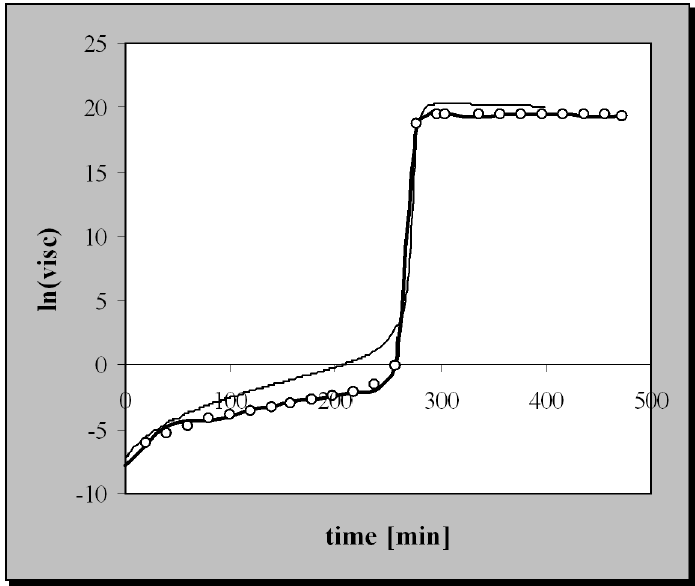
Fig. 13 Mass reaction viscosity obtained with MLP (3:12:4:1) (thick line), with Lyons - Tobolsky equation using kinetic model (thin line) and experimentally (o) [17] at 50 o C and 20.18 mol/m 3